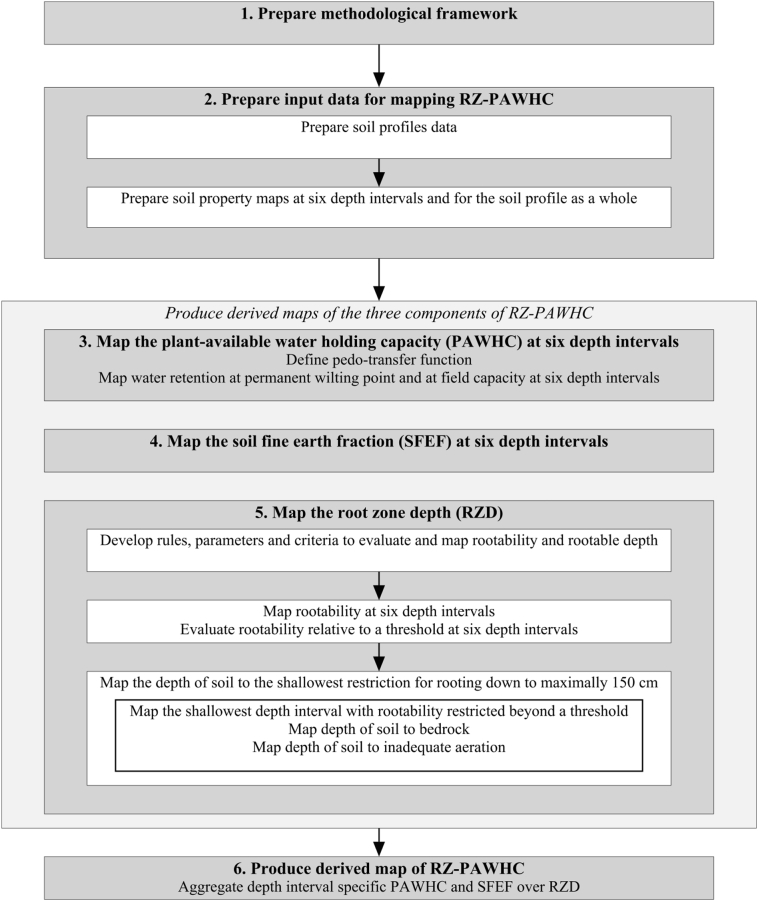
Overview of the methodological framework to map RZ-PAWHC.